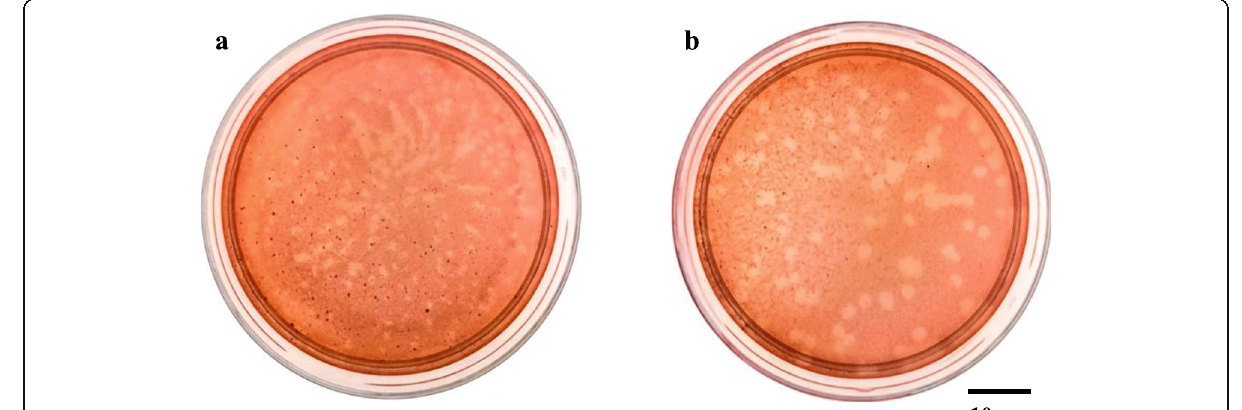
Fig. 1 Plaque sizes of CCoV strains in A-72 cells 3 days post infection. a , JS1706 strain. b , JS1712 strain. Scale bar, 10